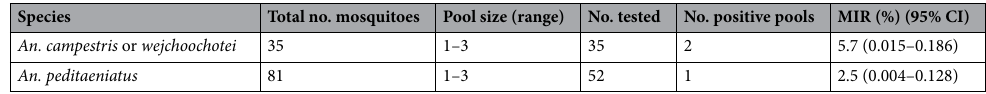
Table 2. Minimum infection rates of Plasmodium in collected mosquitoes.